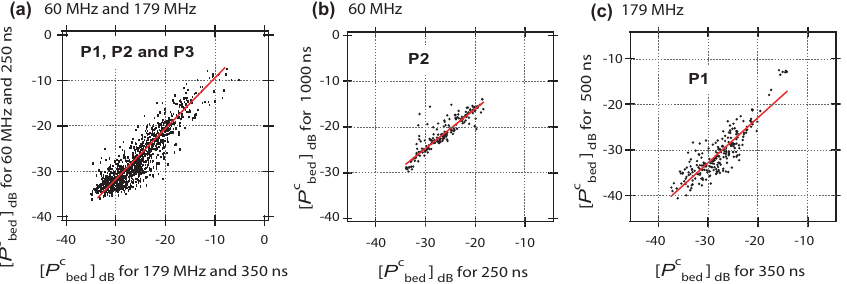
Fig. 4. Variations of [ P c ] dB versus ice thickness H and location x are virtually independent of the radar frequencies and radar pulse widths bed used in the present study. Three examples are shown. (a) For all of the data in Fig. 3 (legs P1 through P3), a scatter plot of the results for two different frequencies was produced. (b) Scatter plot of the results for two different radar pulse widths (1000ns and 250ns) for a radar frequency of 60MHz rfor leg P2. (c) Scatter plot of the results for two different radar pulse widths (500ns and 350ns) for a radar frequency of 179MHz for leg P1. A linear distribution was found for each of these scatter